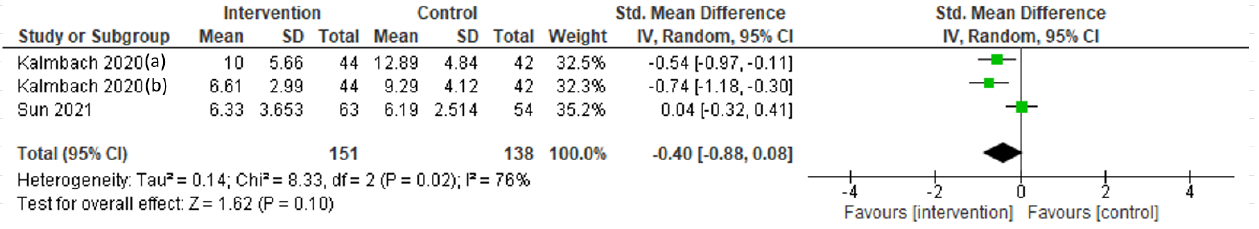
Figure 5 . Sleep quality at the endpoint: Kalmbach 2020 (a, [66]) = ISI; Kalmbach 2020 (b, [66]) = PSQI.